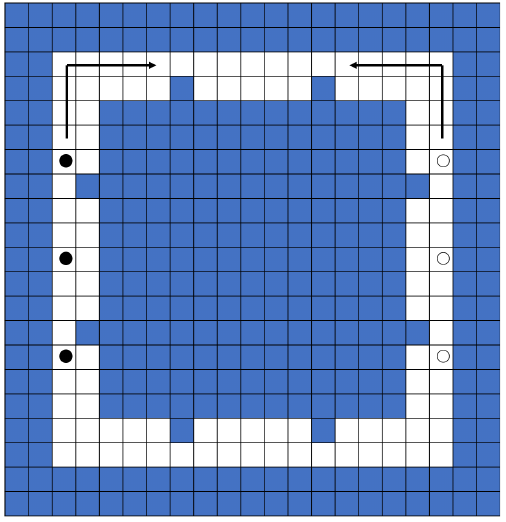
Figure 1. Field and initial position of agents.